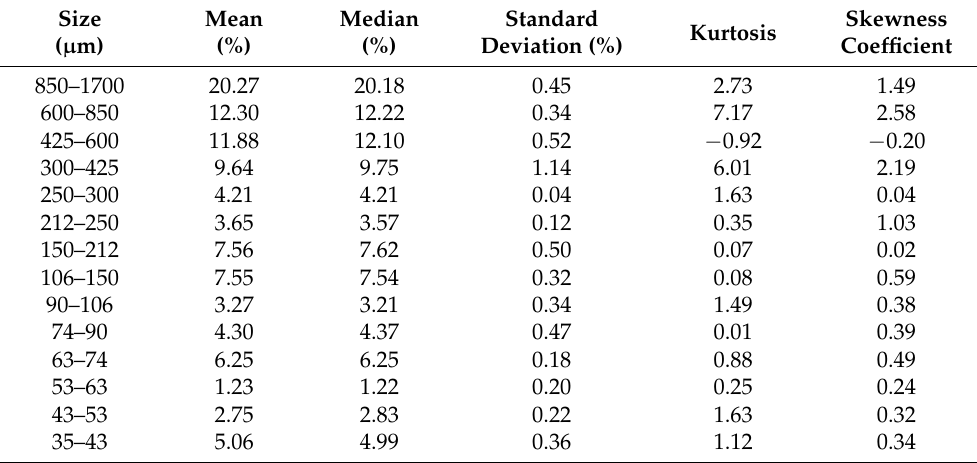
Table A5. Descriptive statistics of the 4 min test for the partial detainees with 95% confidence